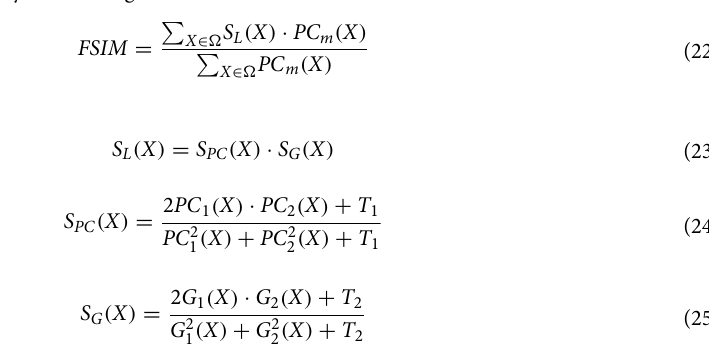
where σ 2 denotes the variance of the image, and σ f 2 denotes the variance of the foregrounds. B T and F T denote the backgrounds and foregrounds region pixels of the original image. Obviously, NU closes to 0 for a well-segmented image and equals to 1 for the worst-segmented image. FSIM calculates the similarity of two images, is defined as: